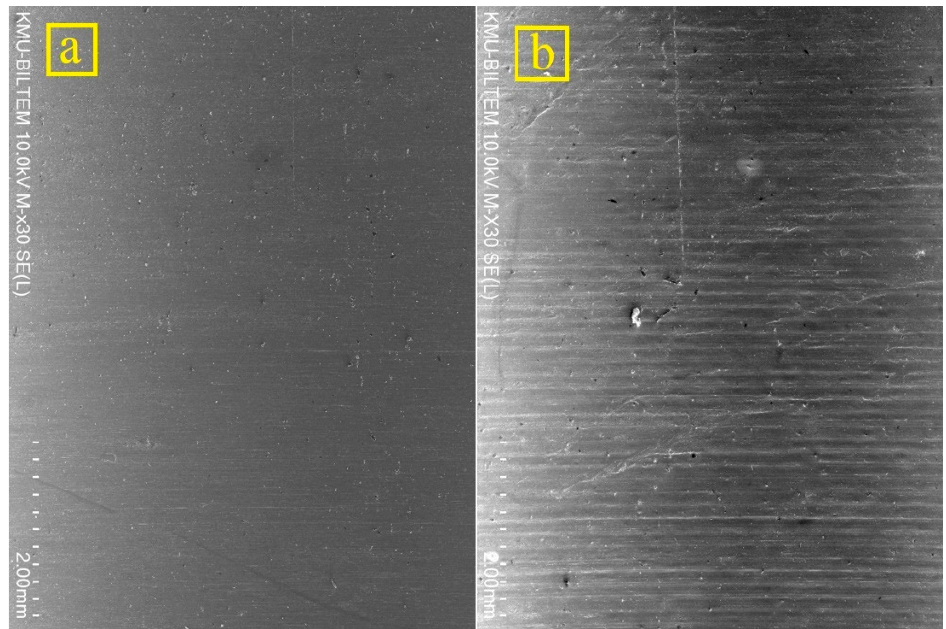
Figure 5. Comparison of hole surface quality in a hole drilled using TiN-coated tools at ( a ) 𝑛 = 2000 rpm and 𝑓 = 1 50 mm/min, and ( b ) 𝑛 = 3000 rpm and 𝑓 = 50 mm/min.